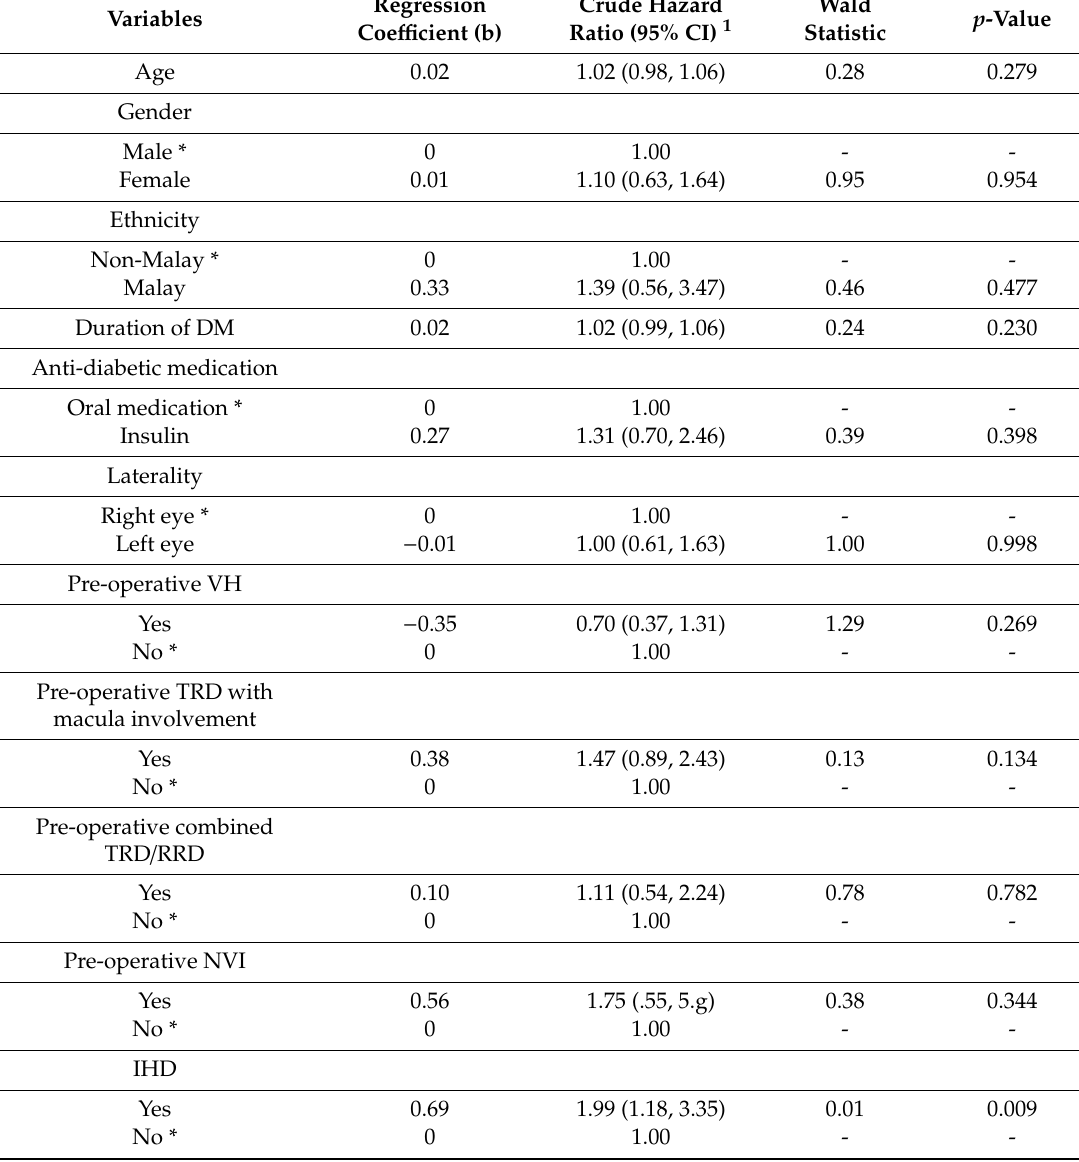
Table 2. Prognostic factors associated with vision loss among subjects with visual improvement post vitrectomy for complications of proliferative diabetic retinopathy (Simple Cox regression) (n =